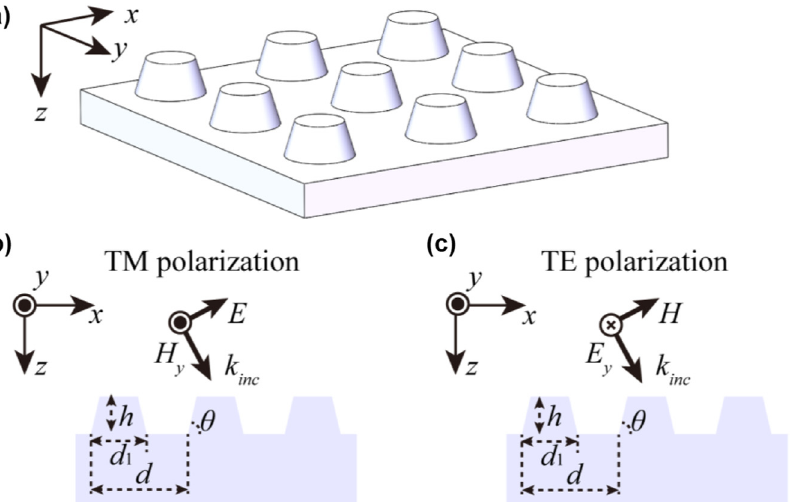
Figure 1: Schematic of two-dimensional grating structure. (a) 3D structure of two-dimensional grating, (b) and (c) represent the grating with transverse-magnetic (TM) and transverse-electric (TE) polarized incident light in xz